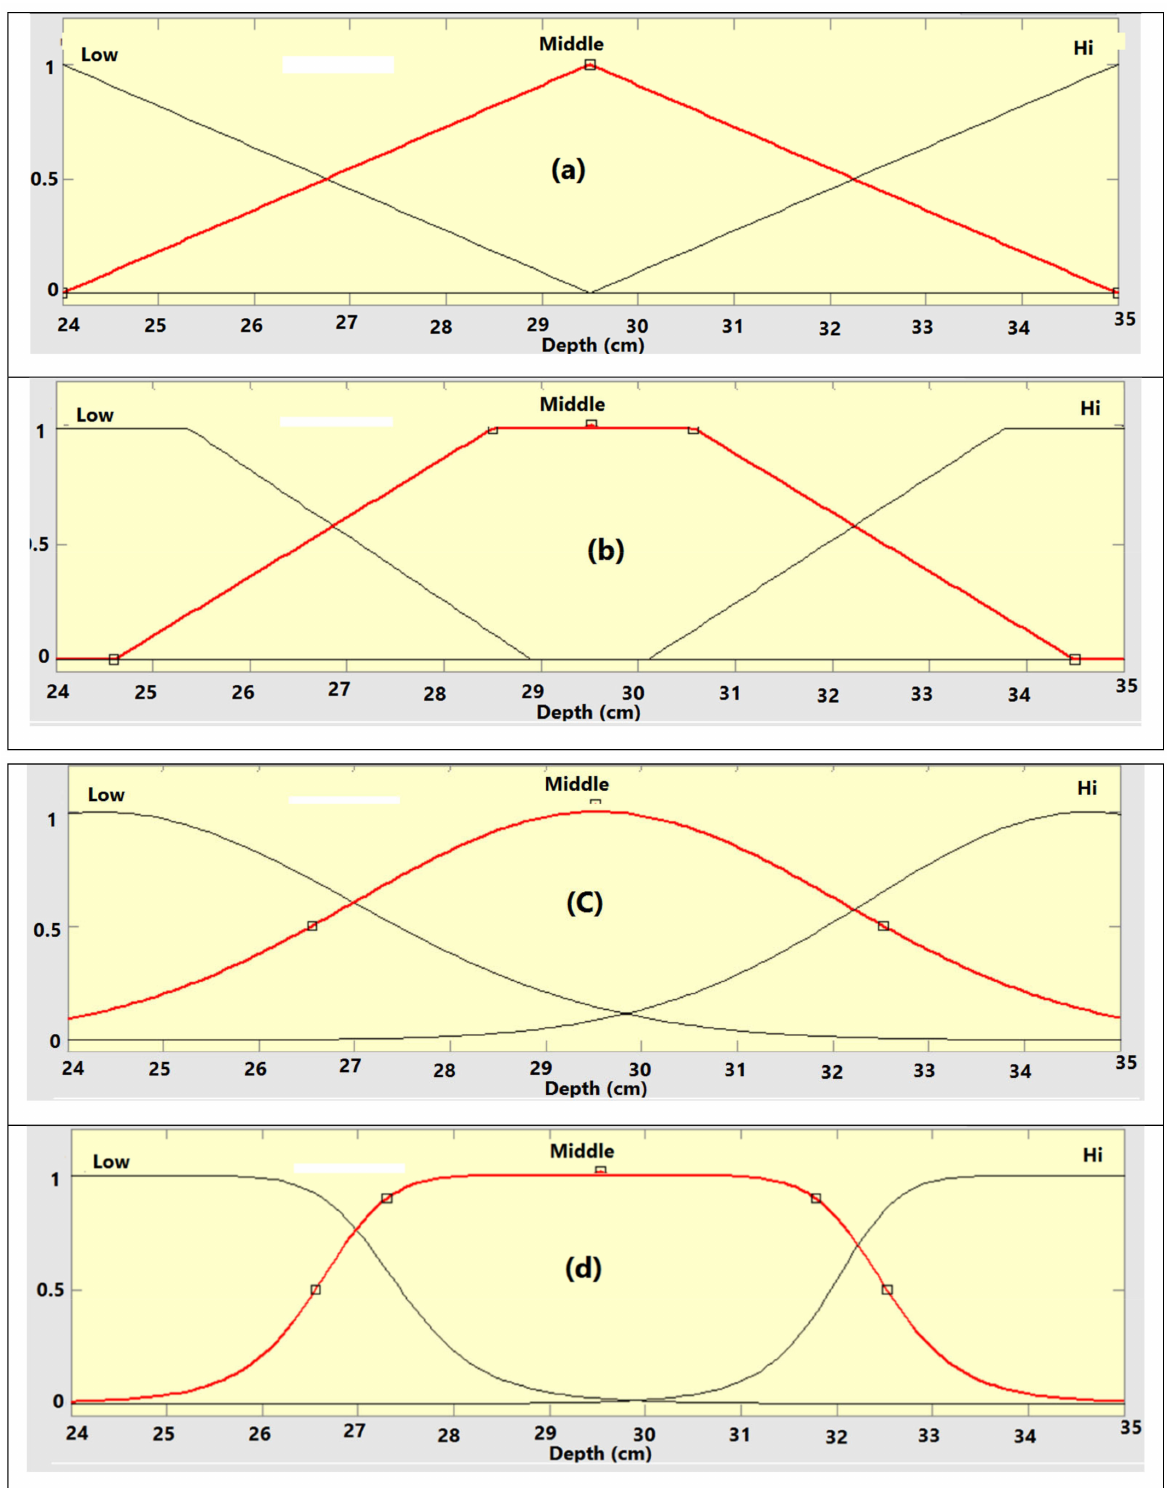
Figure 5. Membership functions used to represent inputs ( a ) Triangular, ( b ) Trapezoidal, ( c ) Gaussian, ( d )